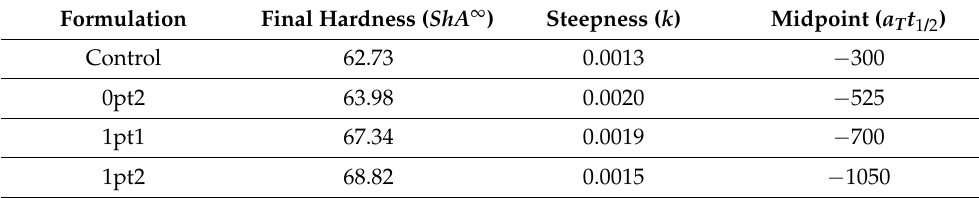
Table A1. Time–temperature superposition Shore A Hardness master curve model parameters. Table A1. Time – temperature superposition Shore A Hardness master curve model parameters.